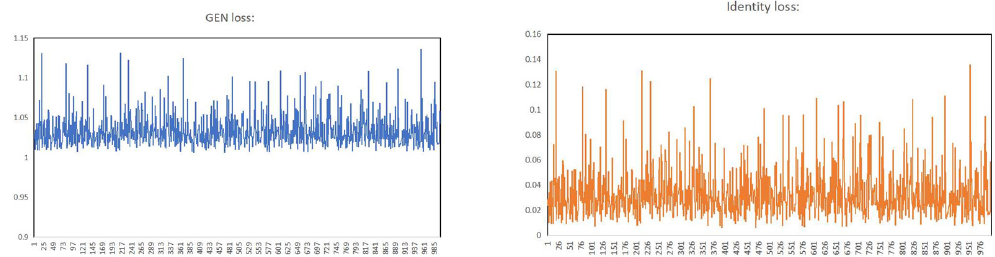
Fig. 9 The Generator loss and Discriminator